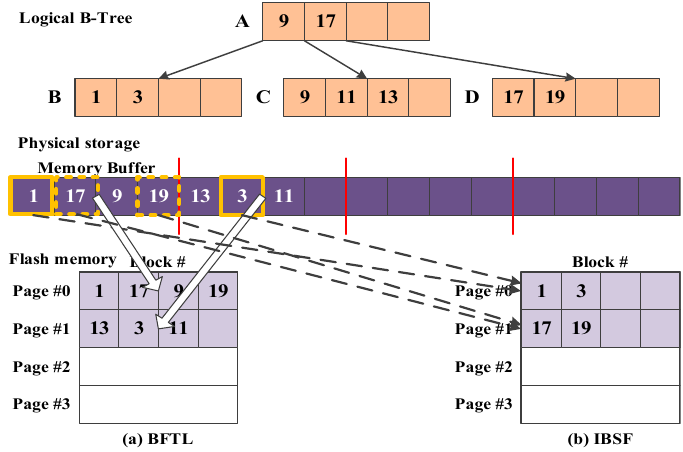
Figure 3. Buffer-based B-Trees for flash memory. Figure 3. Bu ff er-based B-Trees for flash